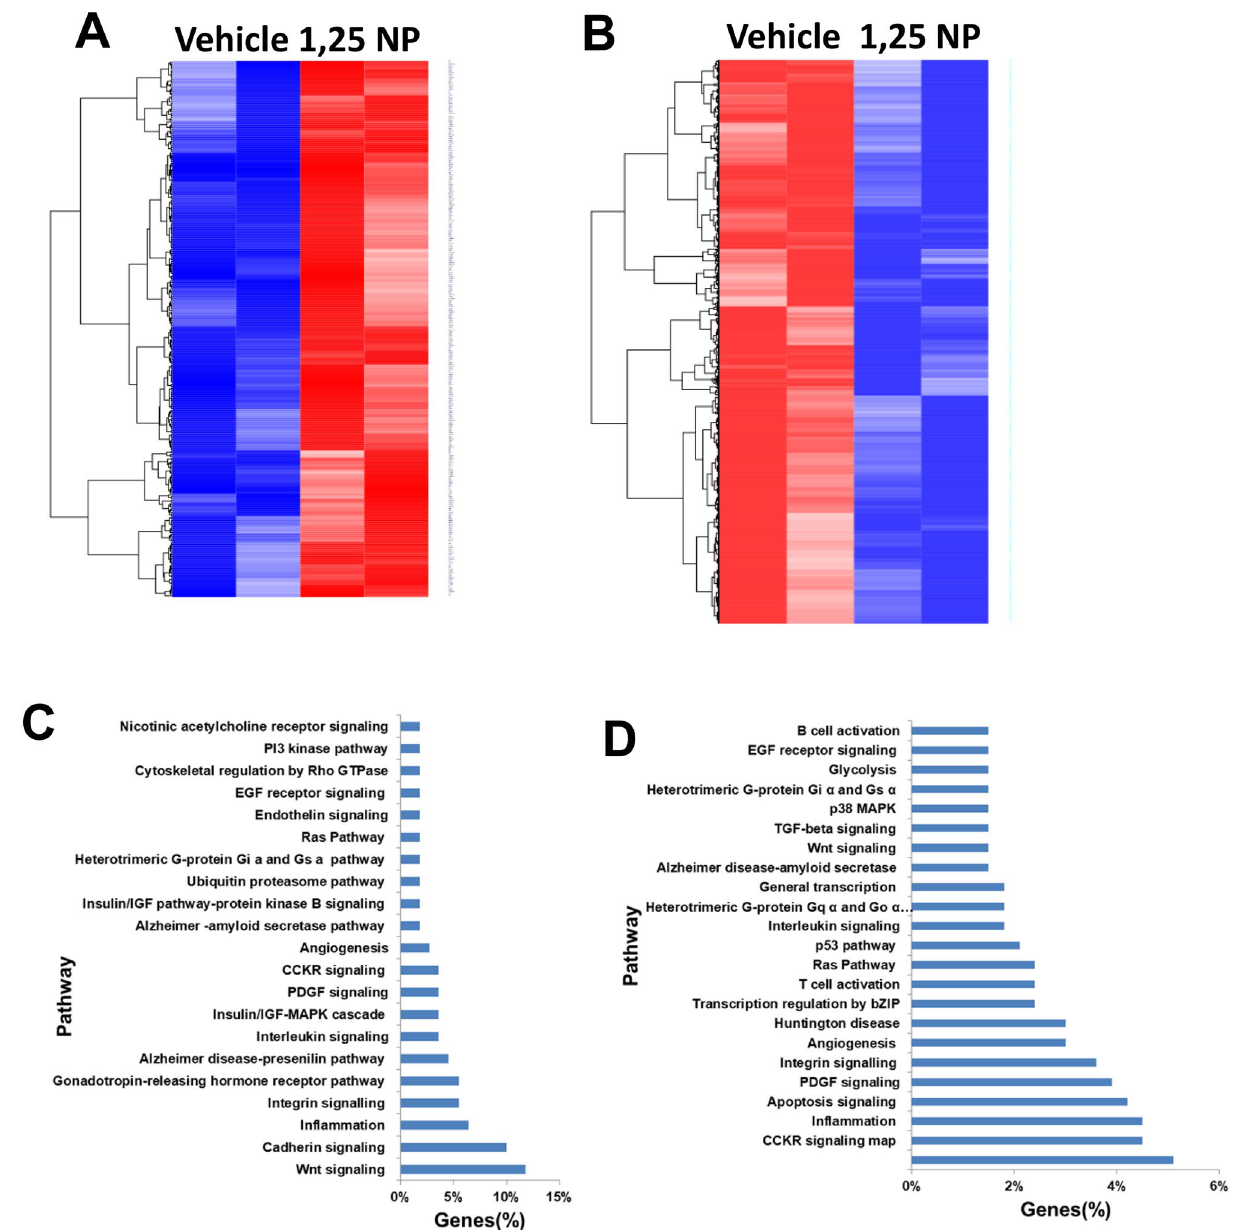
Figure 8. Whole transcriptome analysis using RNA sequencing with differential gene expression and Panther analyses. Unbiased whole transcriptome analysis using RNA sequencing from AVF outflow veins after PTA treated with vehicle controls compared to 1,25 NP. ( A ) Heat map depicting all the genes that are 1.5 fold up or ( B ) 0.75 fold down in outflow veins treated with 1,25 NPs compared to vehicle controls. ( C ) is Panther analysis of differentially regulated genes and in ( D ) shows analysis of downregulated